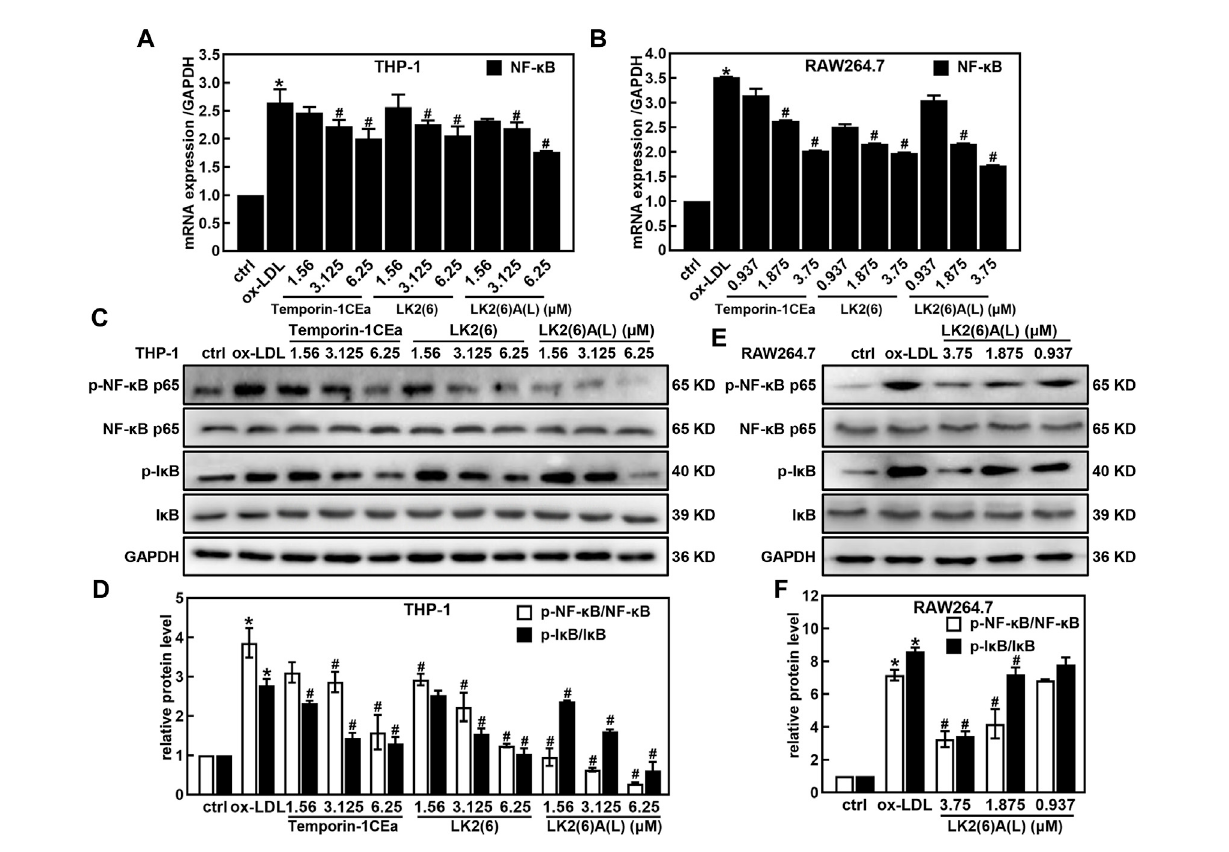
FIGURE 5 Effects of frog skin AMPs on NF- κ B signaling pathway in ox-LDL induced foam cells. mRNA expression of NF- κ B in the foaming THP-1 and RAW264.7cellsbyreal-time quantitativePCR (A,B) ;Expression of p- NF- κ Bp65,NF- κ Bp65, p- I κ BandI κ Bproteininthefoaming THP-1cellstreated with temporin-1CEa and its analogs by Western blot (C,D) ; Expression of p- NF- κ B, NF- κ B, p- I κ B and I κ B protein in the foaming RAW264.7 cells treated with LK2(6)A(L) by Western blot (E,F) and GAPDH was used as an internal reference. * p < 0.05 vs. the ctrl group. # p < 0.05 vs. the ox-LDL